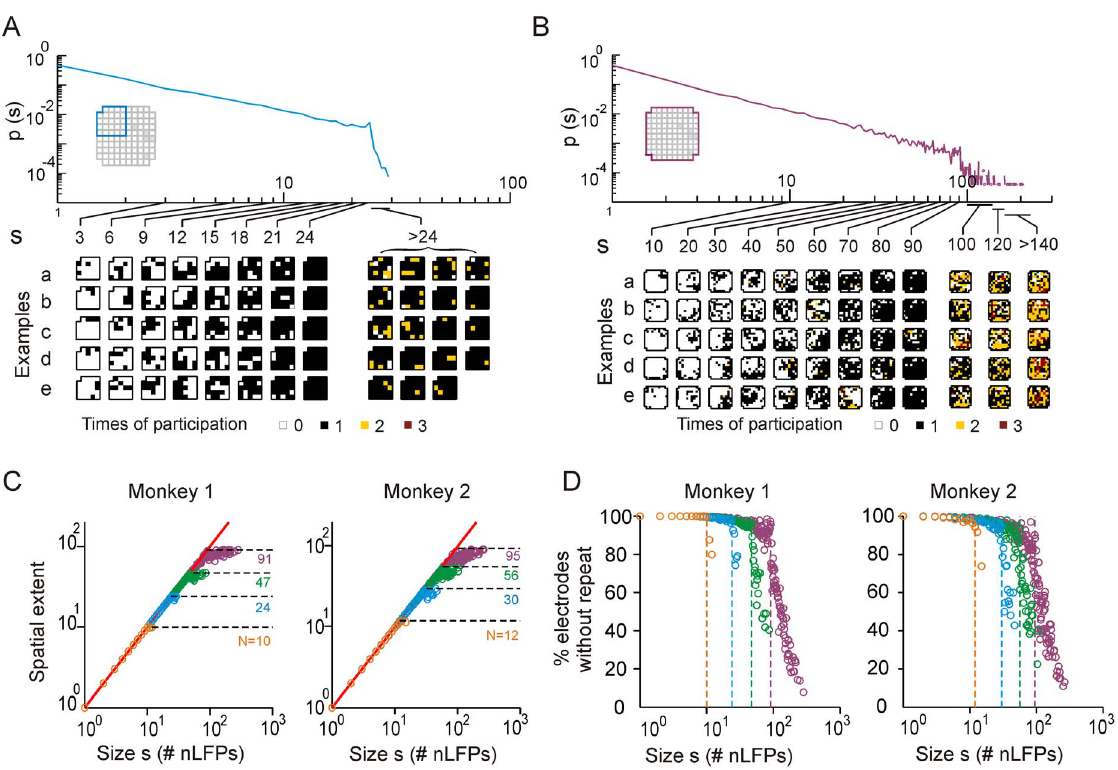
Figure 3. Characteristics of spatial patterns for avalanches observed before and after the cut-off. ( A ) Avalanches observed with a window of N =24 (see inset). Top panel: the probability distribution is redrawn from Fig. 1E (Monkey 1). Bottom panel: five randomly chosen spatial avalanche patterns each are shown for s =3, 6, …, 24. In addition, all 19 spatial patterns for avalanches larger than the observation window size (i.e., s . 24) are depicted. The number of times that any specific electrode participated in a given avalanche is color-coded. ( B ) Same as A for the largest observation window with N =91 electrodes. Only 15 example patterns with s . 91 are depicted. ( C ) The average spatial extent of avalanches, quantified by the number of unique electrodes involved in an avalanche, is plotted as a function of avalanche size for different observation windows. Horizontal dashed lines indicate window size N . The diagonal red line indicates equality. ( D ) Average percentage of electrodes that do not exhibit repeated activation in an avalanche is plotted as a function of the avalanche size for different observation windows. Vertical dashed lines correspond to the different observation window sizes. The observation windows used are the same as those in Figure 1E.